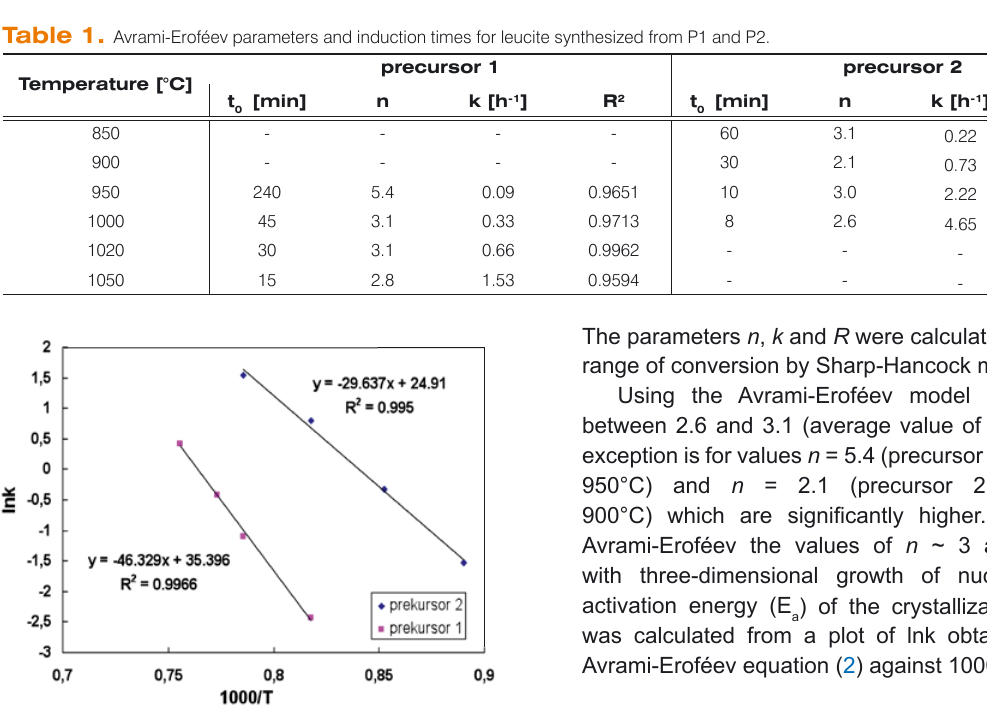
Figure 4. Plots of lnk against 1000/T.